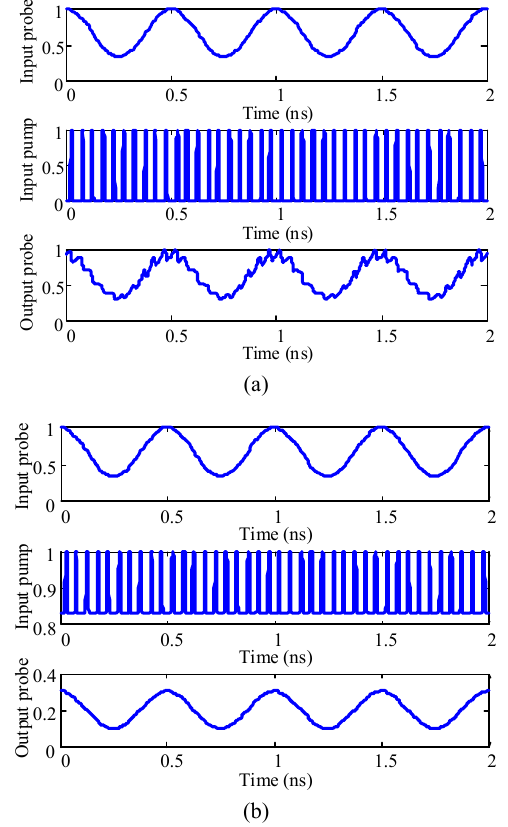
Fig. 5 Sampling results of exchanged probe and pump lights: (a) without holding light and (b) with holding